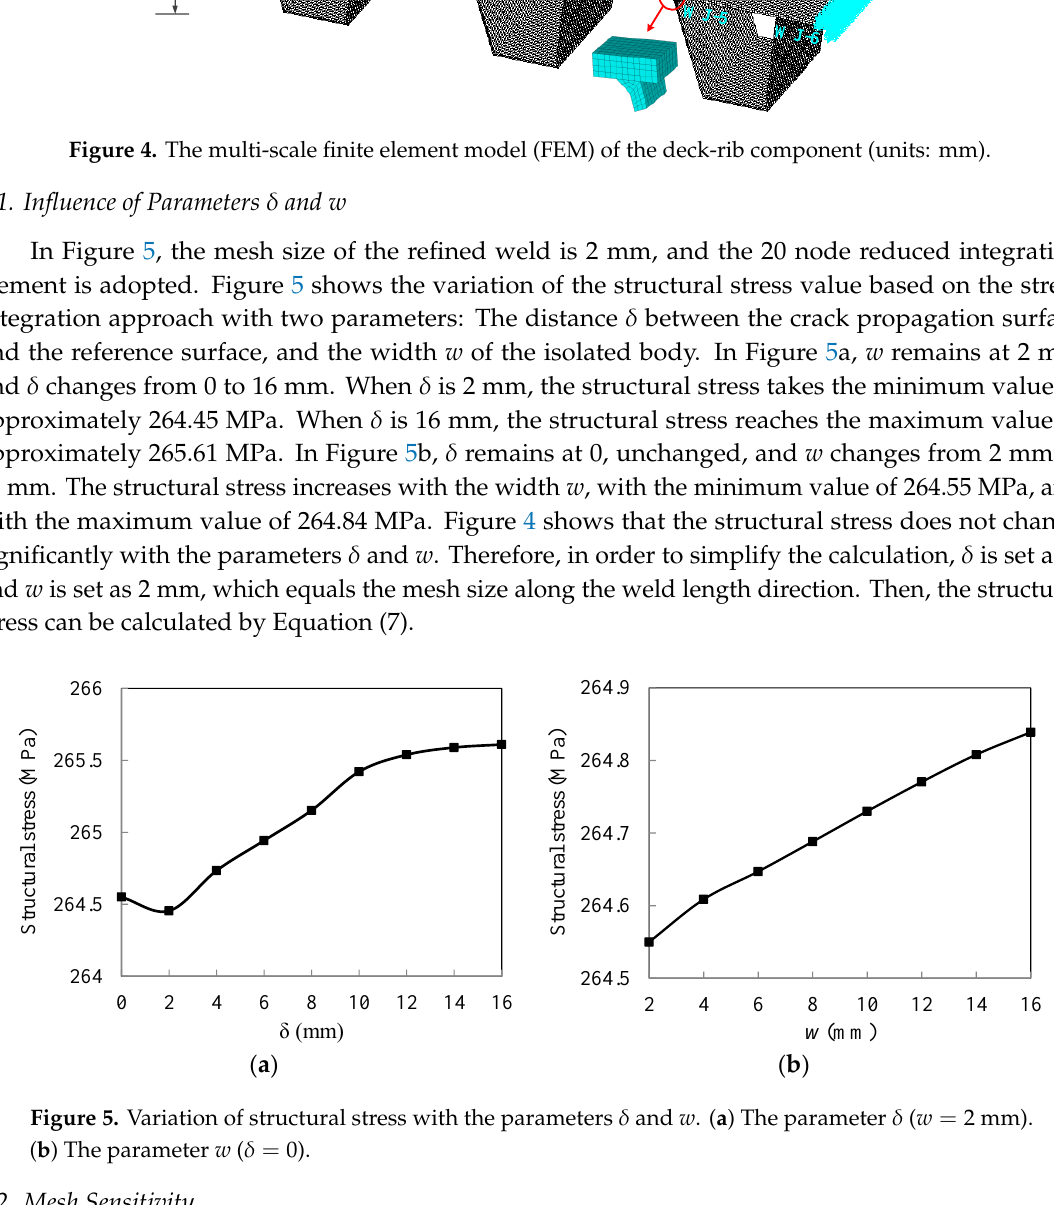
Figure 5. Variation of structural stress with the parameters δ and w . ( a ) The parameter δ ( w = 2 mm). ( b ) The parameter w ( δ = 0 ).